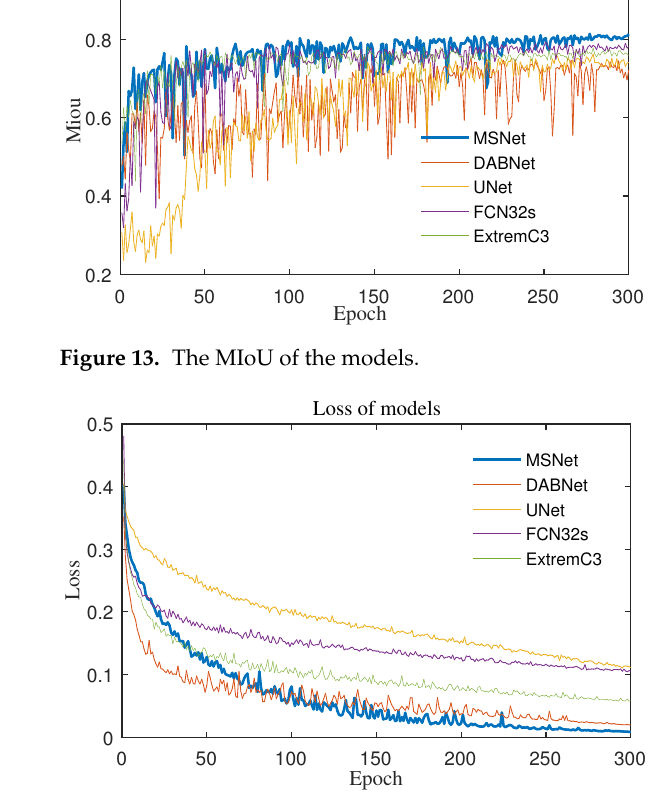
Figure 14. The loss of the